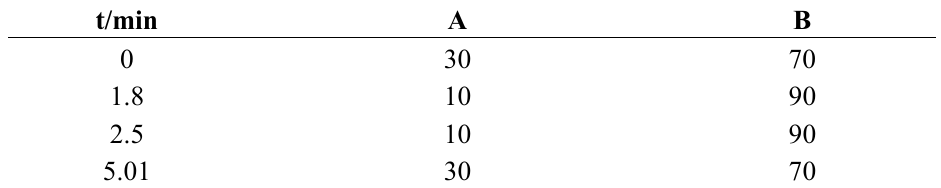
Table 3. The chromatographic gradient elution conditions of the LC-MS